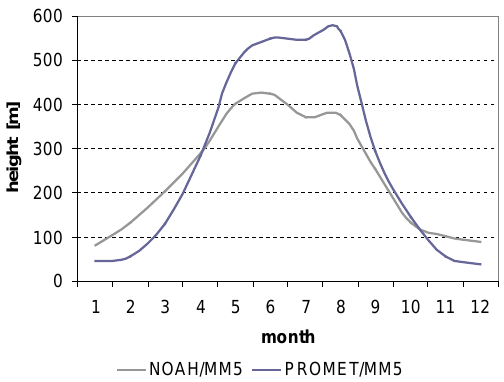
Figure 3: Monthly course of the planetary boundary layer height (1996-1999) of 2-way coupled Fig. 3. Monthly course of the planetary boundary layer height PROMET/MM5 and Noah/MM5 simulations. (1996–1999) of 2-way coupled PROMET/MM5 and NOAH/MM5